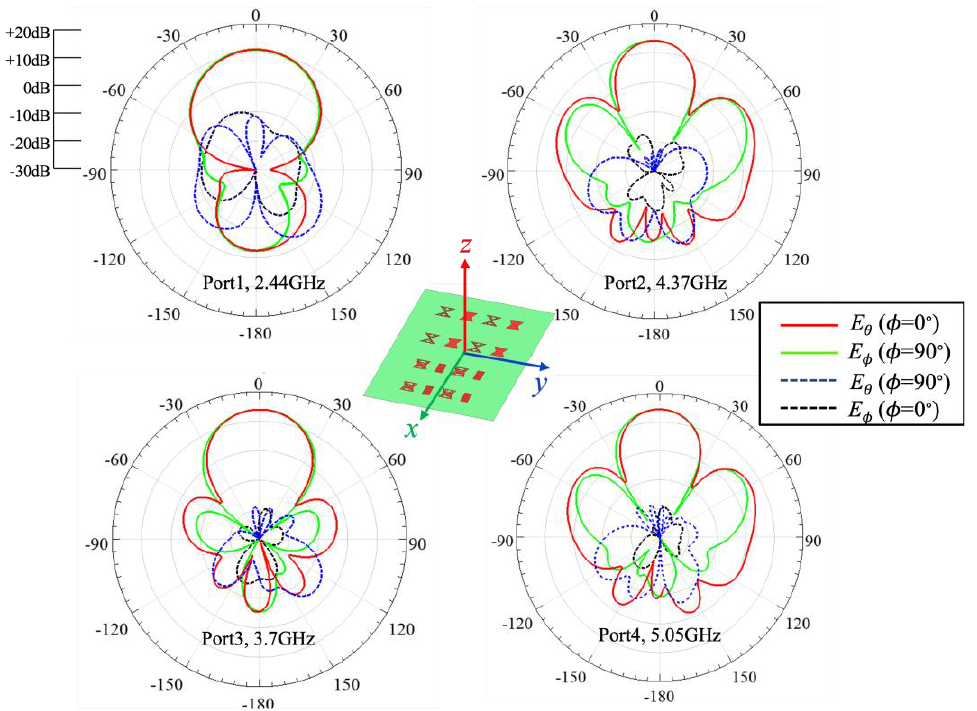
Figure 10. Radiation patterns of the quad-band array antenna. Upper left: port 1; upper right: port 2; lower left: port 3; lower right: port 4.